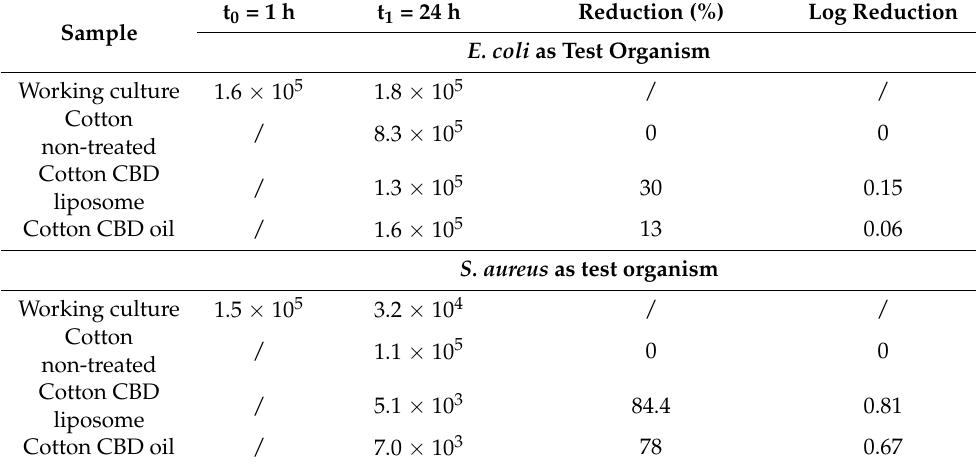
Table 4. Antimicrobial activity of an untreated cotton fibrous sample, a cotton fibrous sample functionalized by CBD liposome liquid formulation, and a cotton fibrous sample functionalized only by CBD